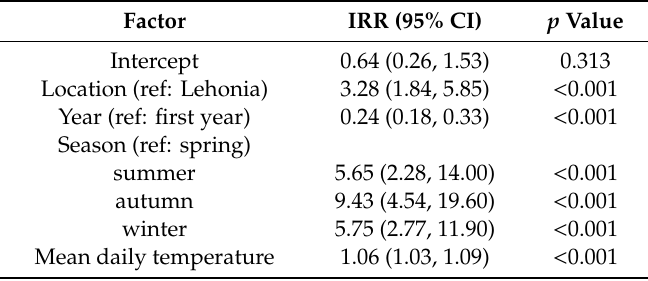
Figure 3. Adult captures per trap per day and LOESS curves (Locally Estimated Scatterplot Smoothing curves) for Lehonia and Agia Fotini from 26 March 2018 to 22 March 2020. Table 3. Variables of the generalized estimating equations GEEs with significant e ff ects on the total trap captures of adult Drosophila suzukii in the two locations